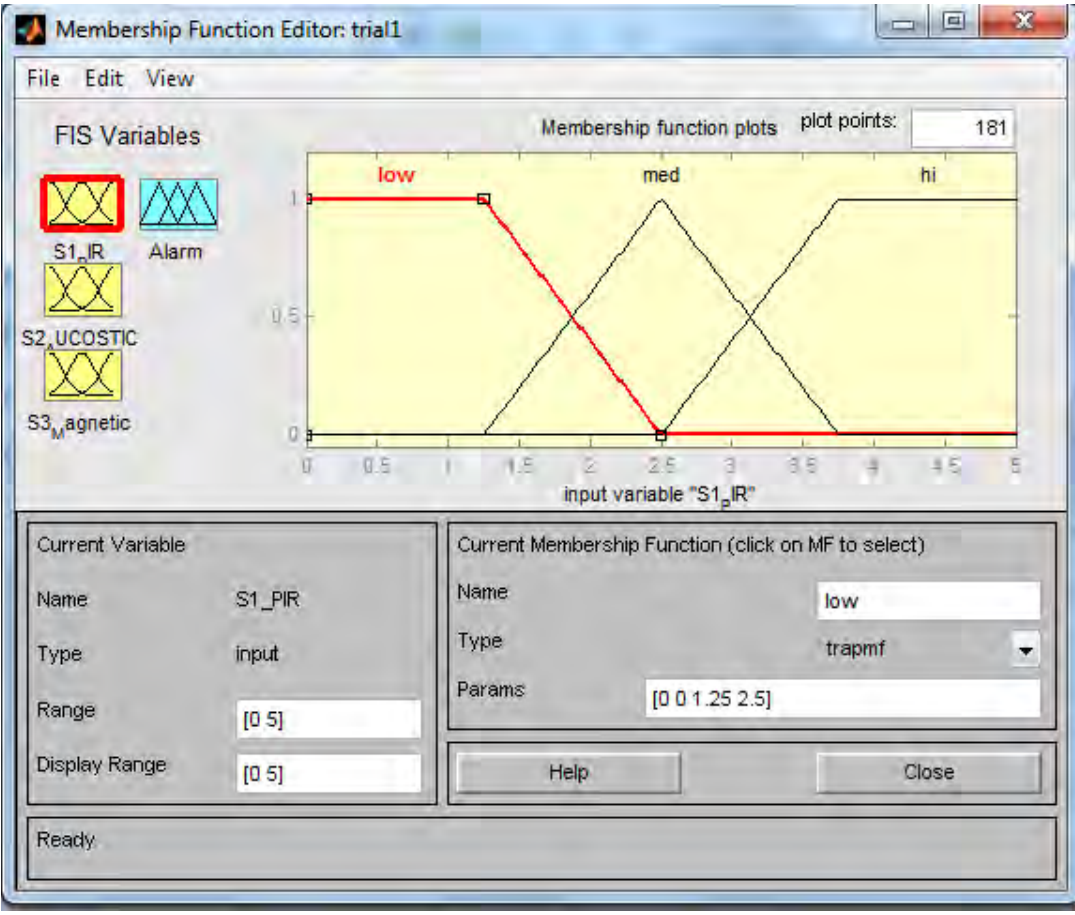
Figure 6. PIR membership